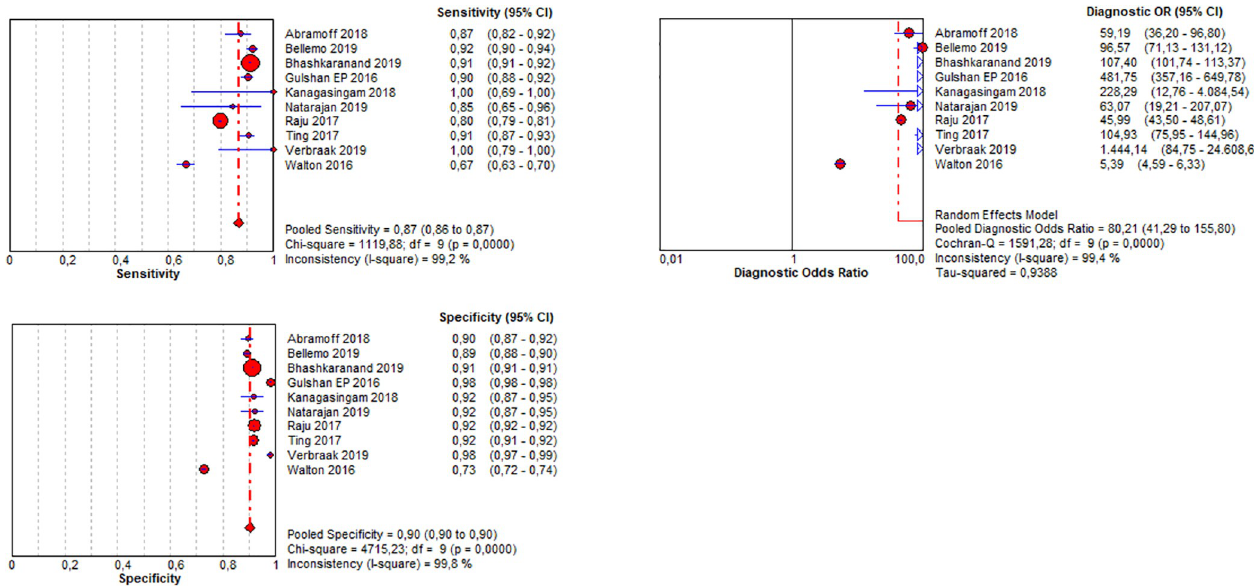
Fig 2. Pooled sensitivity, specificity and diagnostic odds ratio of any DR.